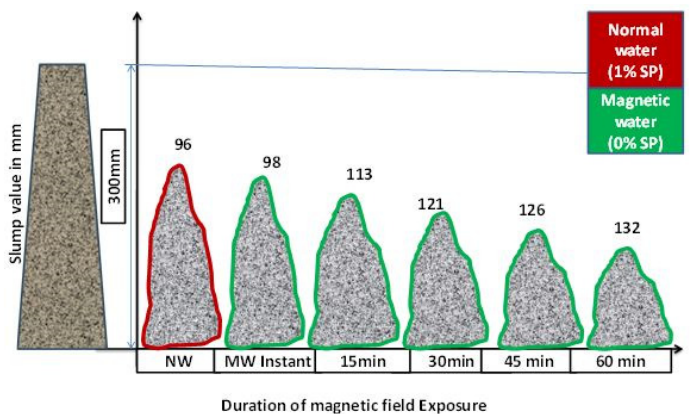
Figure 6. Different exposure time is slump values of concrete (NW with 1% optimized SP and MW with 0% SP).